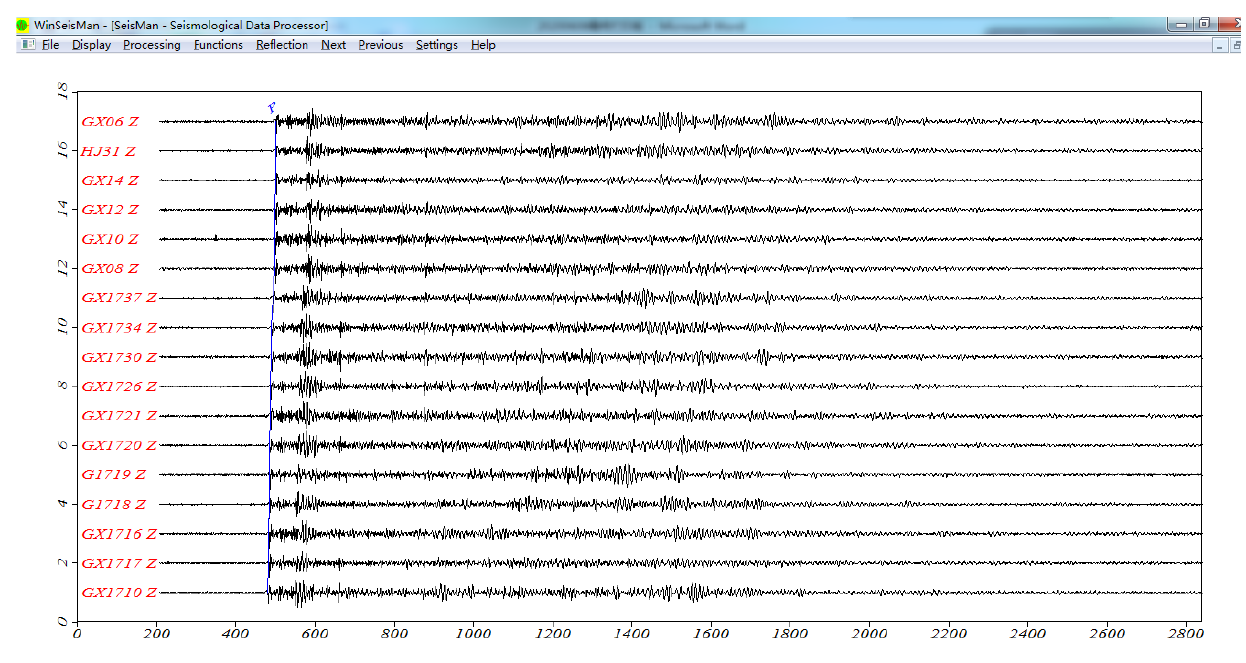
Figure 8. Seismic data and theoretical traveltimes (band-pass filtered).